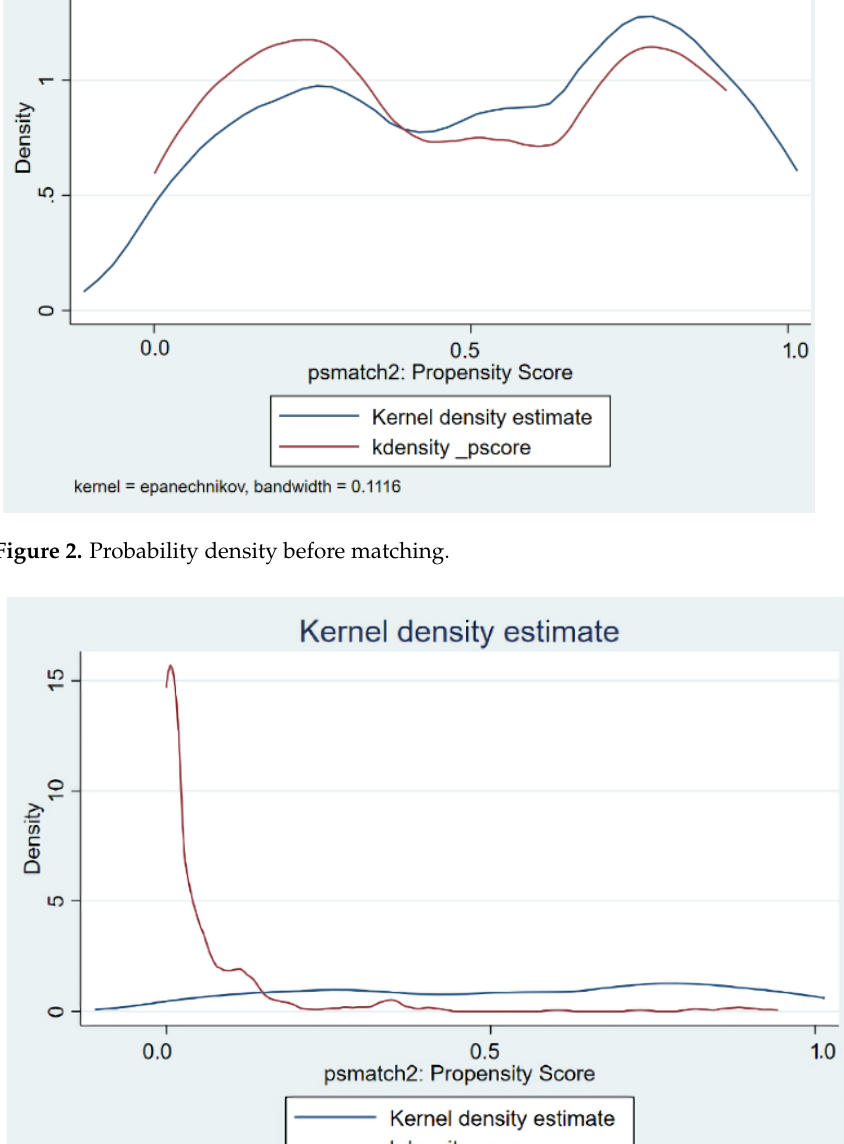
Table 3. PSM covariate data balance test.